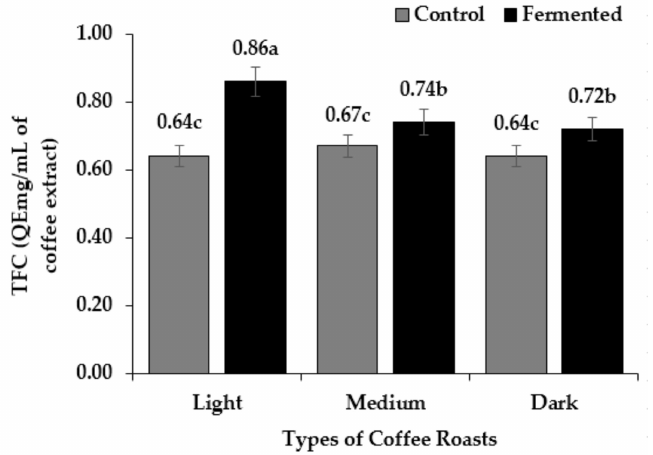
Figure 7. Total flavonoid contents (QE mg / mL of co ff ee extract) of fermented co ff ee. Bars with di ff erent letters indicate a significant di ff erence ( p < 0.5) among